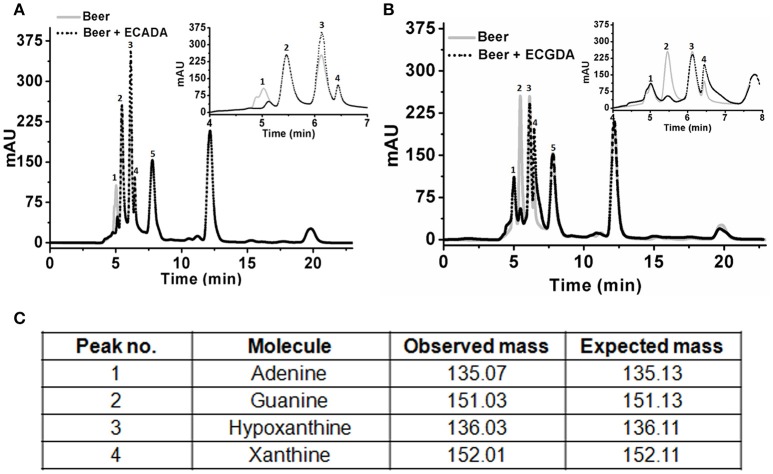
Chromatogram of beer sample before and after the enzyme treatment. (A) The chromatogram shows purine content in beer before (dotted black line) and after KlacADA enzyme reaction (solid gray line). (B) The chromatogram shows purine content in beer before (dotted back line) and after KlacADA enzyme reaction (solid gray line). Beer sample treated with 0.5 U of KlacADA and KlacGDA enzymes. In the panel, A adenine peak (1) was decreased and hypoxanthine peak (3) was increased. In the panel, B guanine (2) peak was decreased and xanthine (3) peak intensity was increased suggesting the conversion of adenine and guanine into hypoxanthine and xanthine, respectively. (C) LC-ESI-MS analysis of purines in beer: 1- Adenine, 2- Guanine, 3- Hypoxanthine, 4- Xanthine, expected and observed the molecular mass of purines.